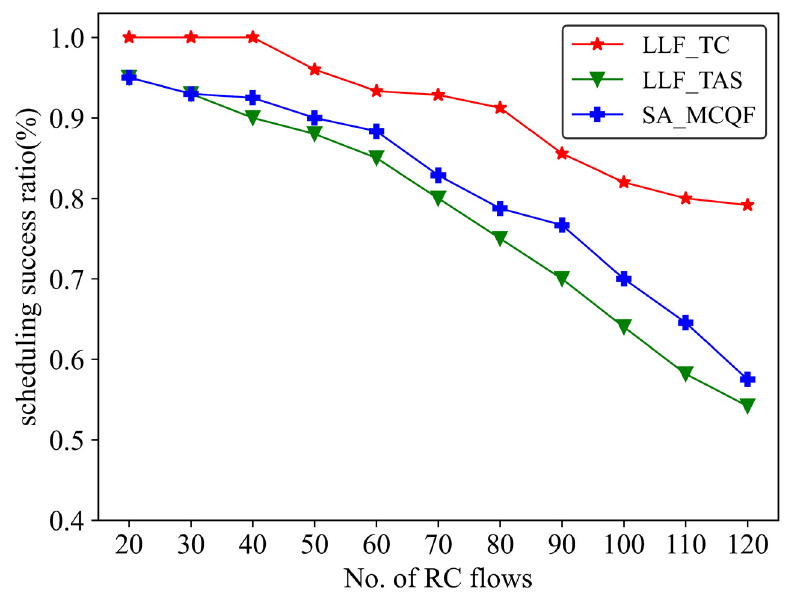
Figure 8. Success ratio of RC traffic scheduling under different scheduling mechanisms.